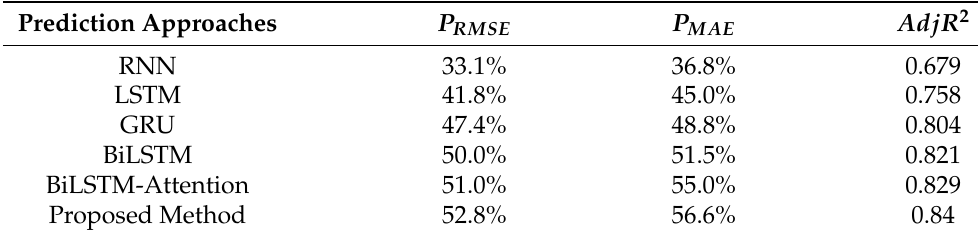
Table 2. Percentage Improvement of Methods in Comparisons with MLP (dataset A).